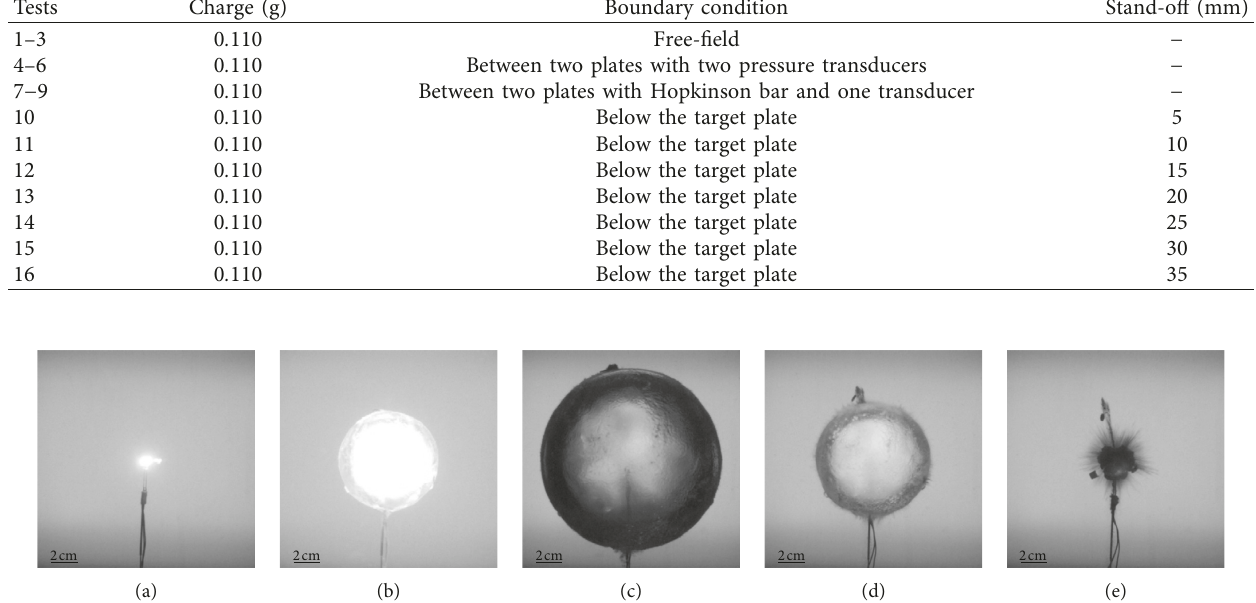
Figure 5: Evolution of the first cycle of the underwater explosion bubble’s expansion and collapse in a free field generated by the explosive charge of 0 . 11 g. (a) t � 0.0000ms. (b) t � 1.0000ms. (c) t � 6.6429ms. (d) t � 11.0000ms. (e) t � 12.5000ms.